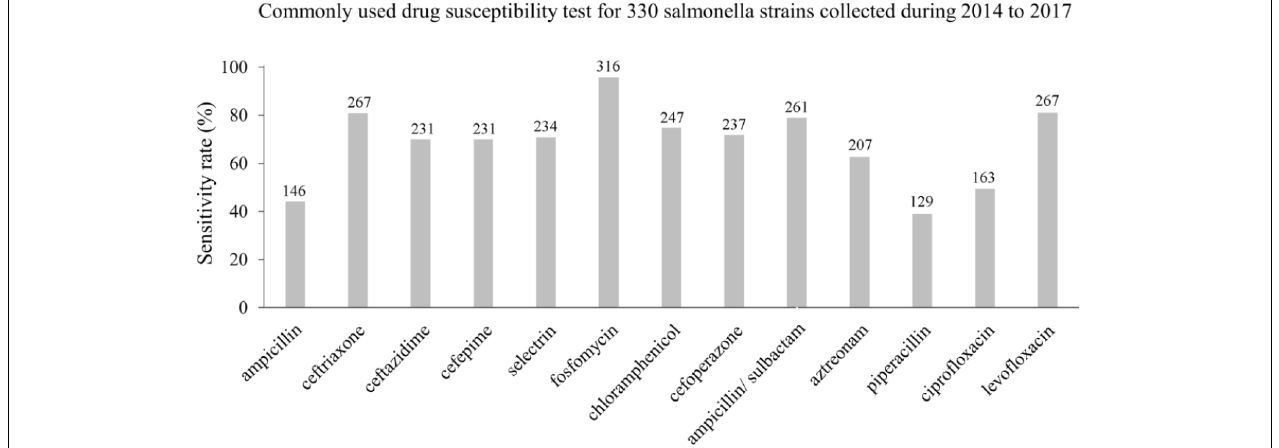
FIGURE 4 | The susceptibilities of Salmonella infections to 13 antibiotics in the Southwest of Shanghai between 2014 and